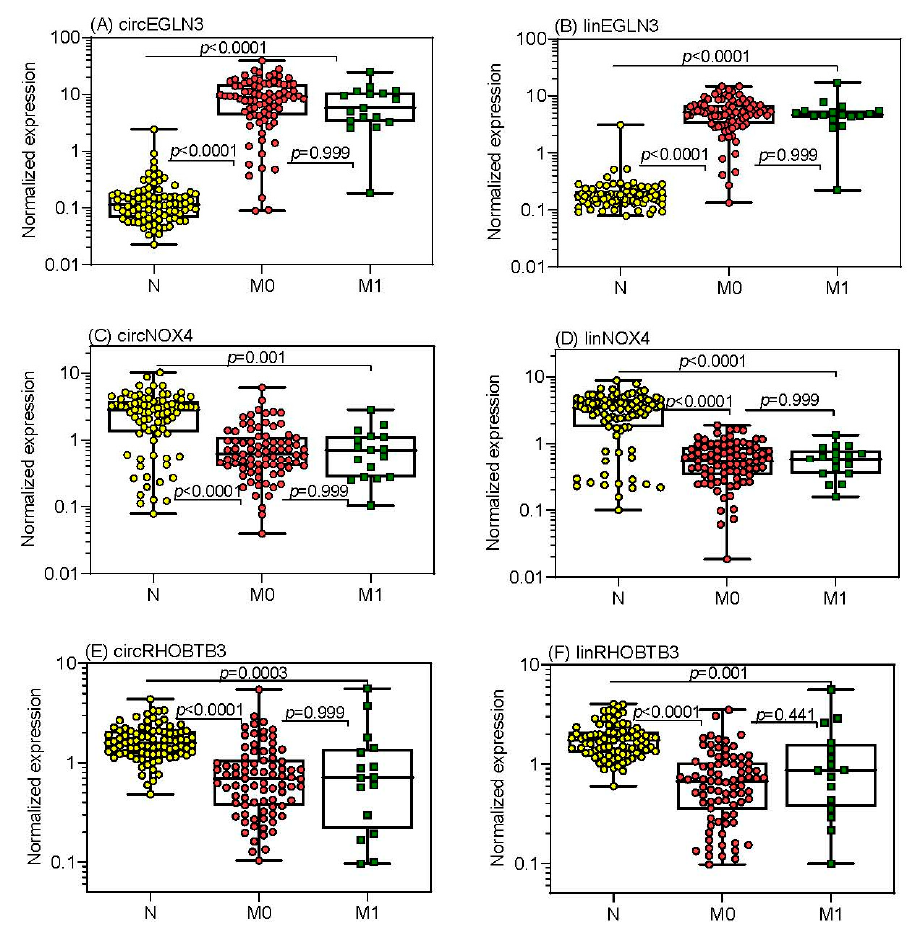
Figure 4. Expression of circular RNAs (circRNAs) and the linear transcripts of their host genes in tissue samples from patients suffering from clear cell renal cell carcinoma. Expression data of ( A ) circEGLN3, ( C ) circNOX4, and ( E ) circRHOBTB3 as well as the corresponding linear transcripts of the host genes ( B ) EGLN3, ( D ) NOX4, and ( F ) RHOBTB3 are shown in adjacent normal tissue distant from tumor ( n = 85), in tissue from non-metastatic (M0, n = 82) and metastatic primary tumors (M1, n = 17) of patients with clear cell renal cell carcinoma at the time of surgery. CircRNA and linRNA expression ratios of M0 ( n = 60) and M1 ( n = 16) tissue samples in relation to their paired adjacent normal tissue samples did not statistically differ ( p values between 0.302 to 0.712). PPIA (peptidylprolyl isomerase A) mRNA and TBP (TATA-box binding protein) mRNA were used as normalizers. Boxes in the box-and whisker plots represent the lower and upper quartiles with medians, whiskers illustrate the entire range of the samples. Significant differences between the study groups were estimated by the Kruskal-Wallis test with multiple comparisons corrected according to Holm-Sidak.